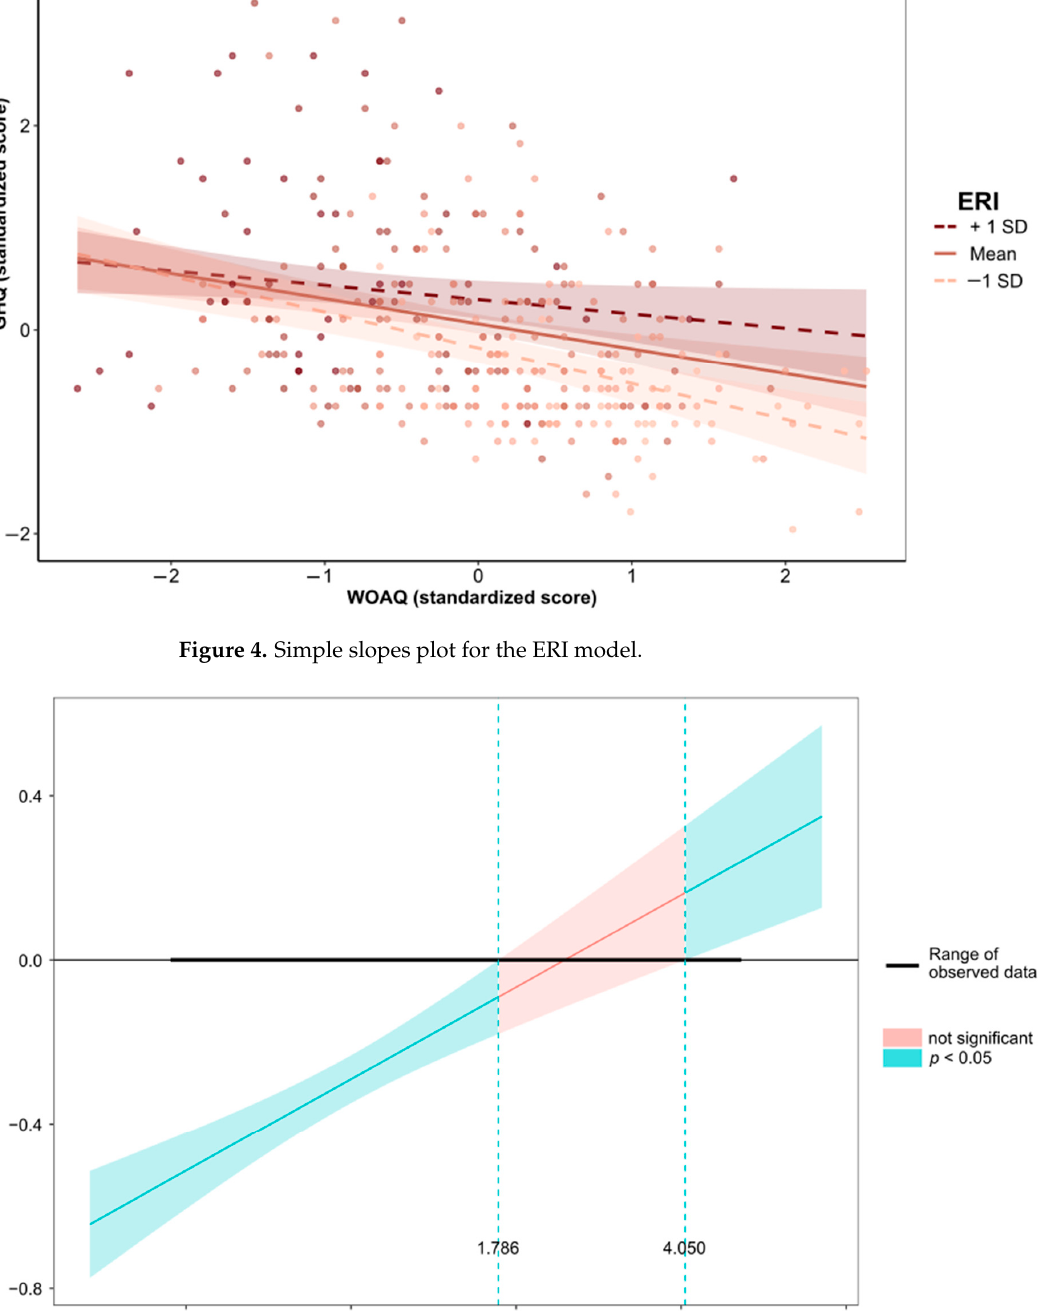
Figure 5. Johnson–Neyman Plot of the relationship between work organization quality and psycho- logical health, moderated by job strain.